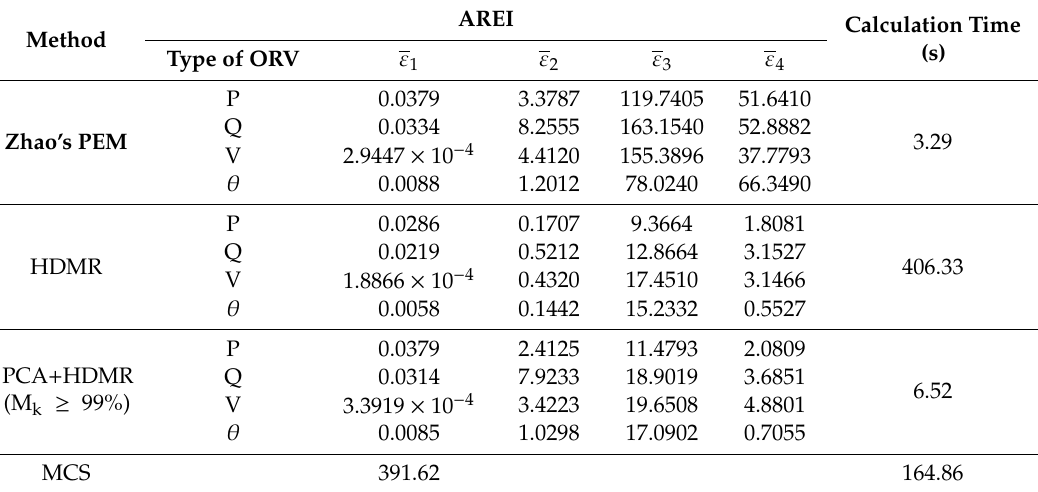
Table 6. Performance of evaluated methods